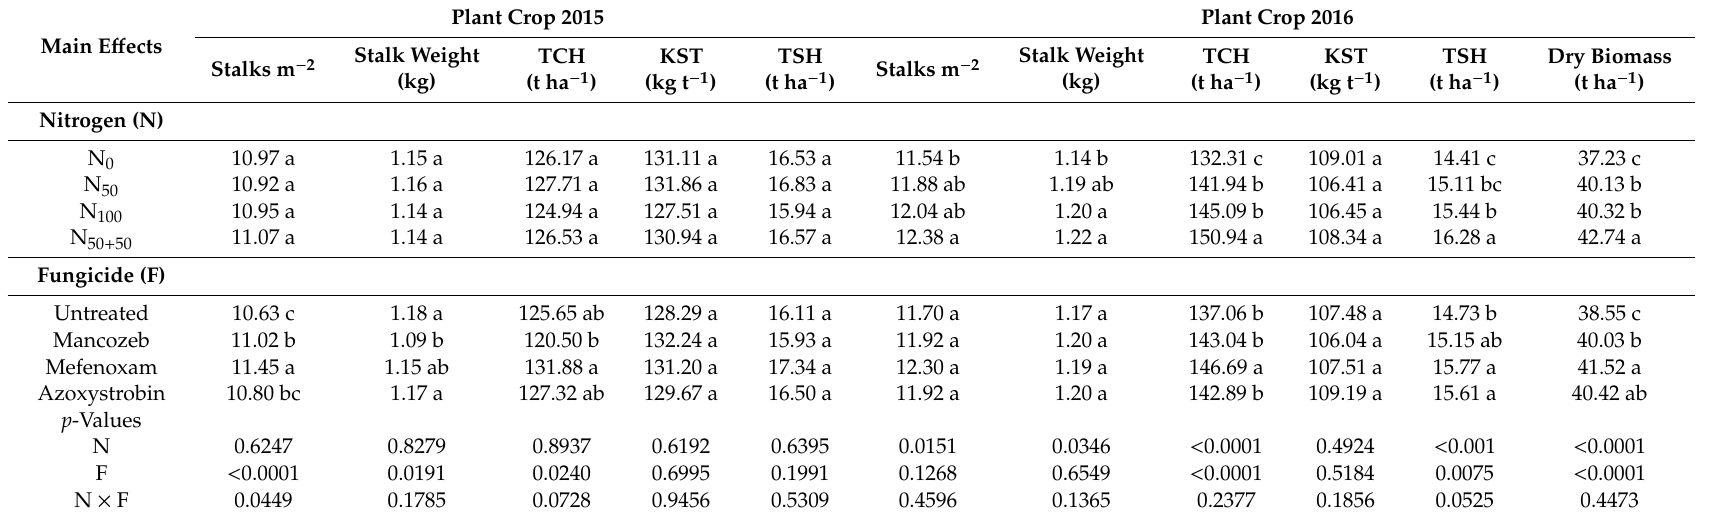
Table 8. Least Square means of sugarcane yield attributes and yields in nitrogen and fungicide treatments in 2015 and 2016 plant crops.